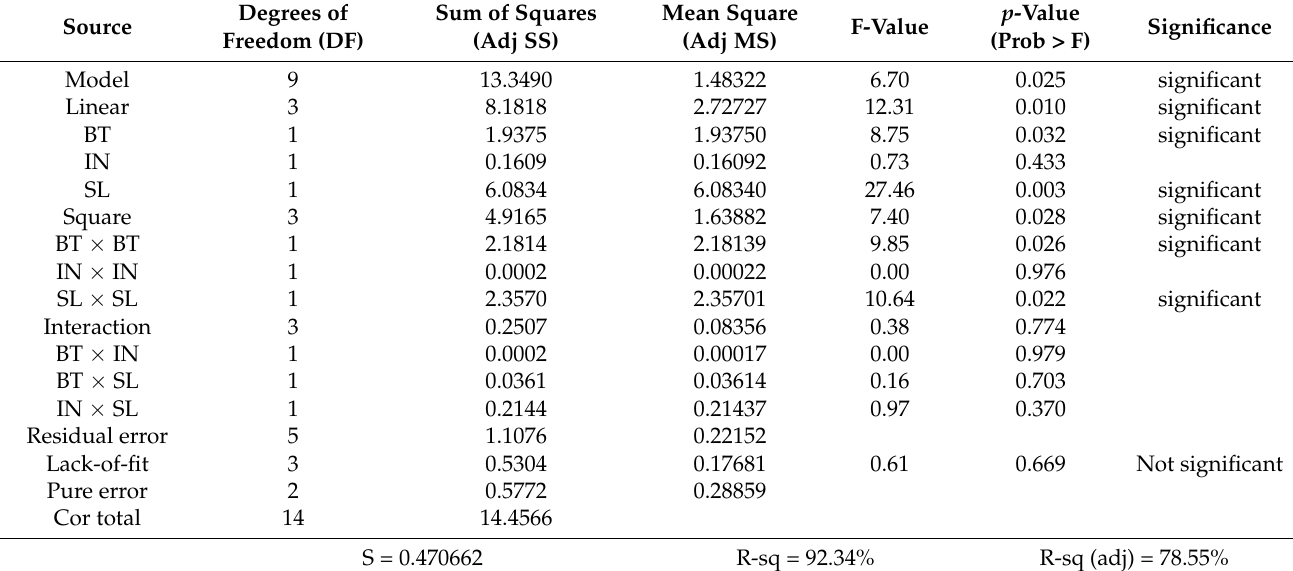
Table 5. ANOVA results of